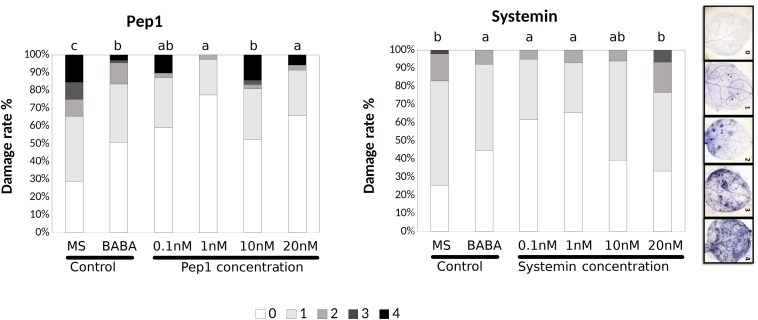
Pep1 and Systemin induced-resistance assays against Plectosphaerella cucumerina in Arabidopsis plants. Infection levels 5 days after inoculation quantified by a disease rating in trypan blue stained leaves, measured as a percentage of the infected leaf surface. Arabidopsis Col-0 plants were treated with increasing concentrations of Pep1 or Systemin (0.1, 1, 10, and 20 nM) 24 h before infection with 1 μl droplets of 5 × 10E3 spores/ml of P. cucumerina BMM. ß-amino butyric acid (BABA) at 1 ppm was used as a positive control. Colors mean % of diseased leaves in a scale (0 = healthy leaves; 1 = leaves with less than 25% of diseased surface; 2 = leaves with 25–50%; 3 = leaves with 50–75% of the diseased surface, 4 = leaves with more than 75% of the surface diseased). Different letters indicate statistically significant differences (ANOVA, Fisher’s Least Significant Difference (LSD) test; P < 0.05, n = 24). The experiment had 6 plants per treatment and was repeated at least three times with similar results.